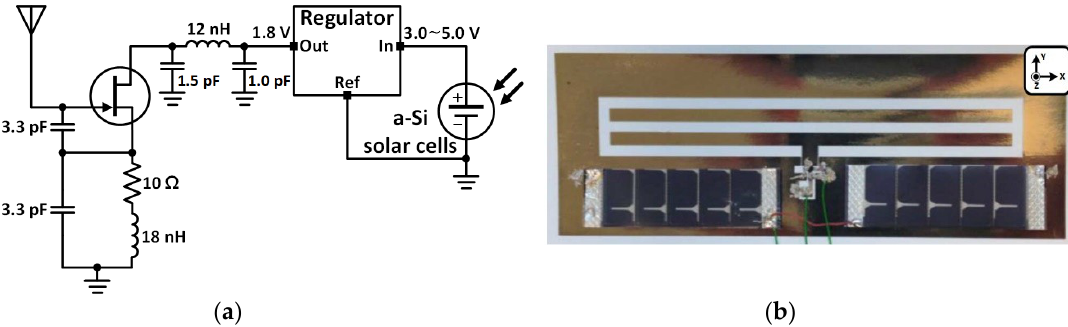
Figure 4. A solar-powered active antenna (solar-to-RF power converter): ( a ) System schematic and ( b ) fabricated RF active antenna.